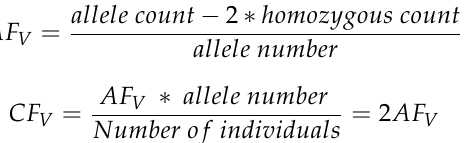
Table 1. Presumed (likely) pathogenic variants in 12 genes associated with autosomal recessive congenital hypothyroid found in gnomAD. No. of Presumed Pathogenic or Likely Pathogenic Variants Group Gene